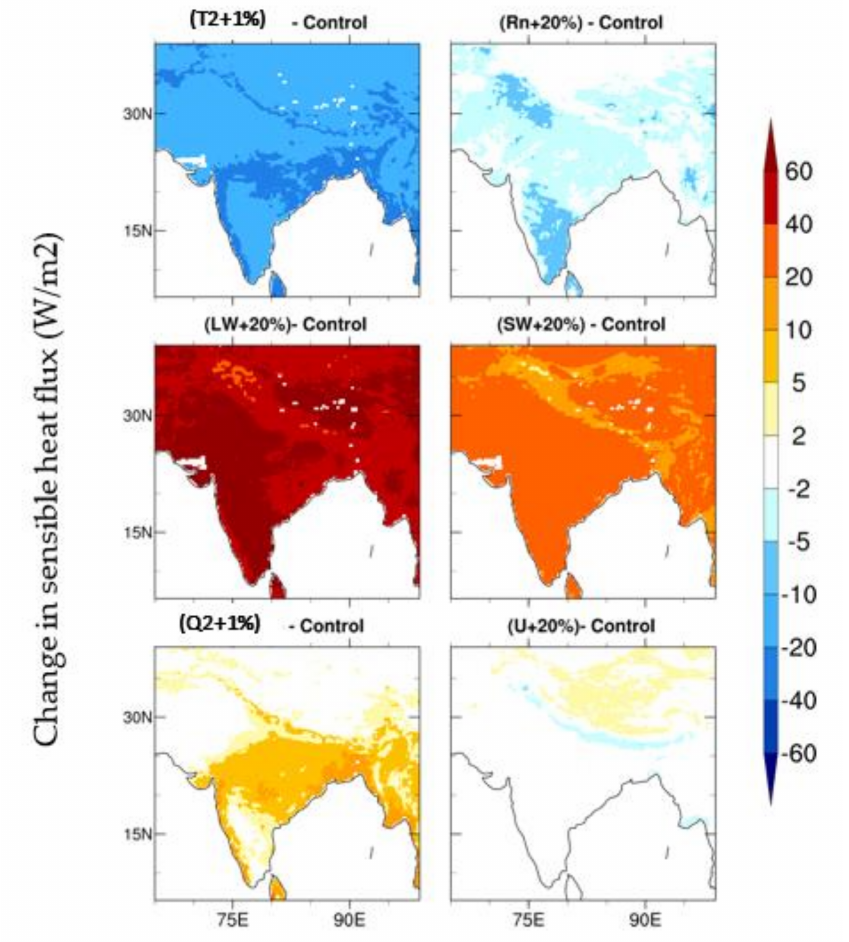
Figure 8. Annual sensible heat flux change (W/m 2 ) due to the positive sensitive experiments compared to the control experiment during the year